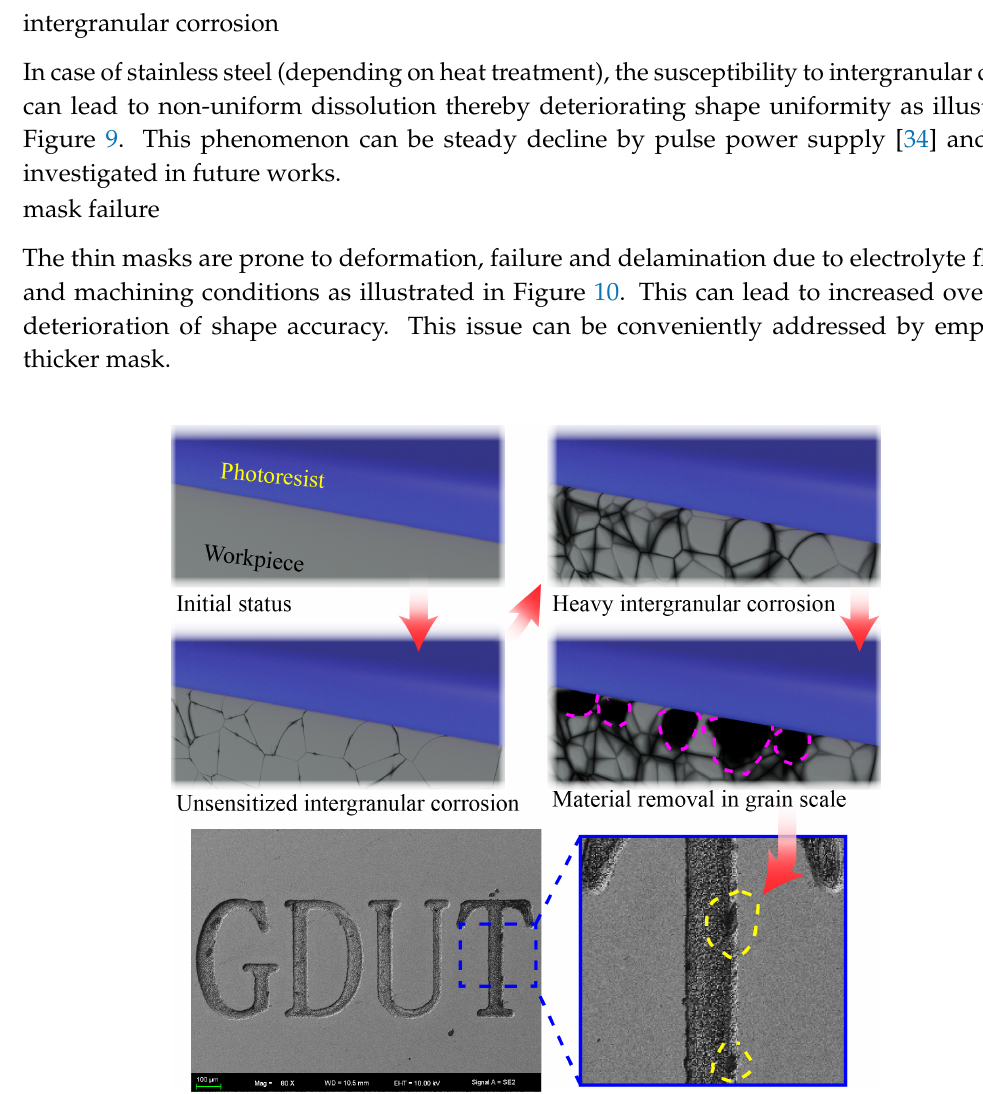
Figure 9. Illustration of intergranular corrosion in MEJM and its effect on fabricated